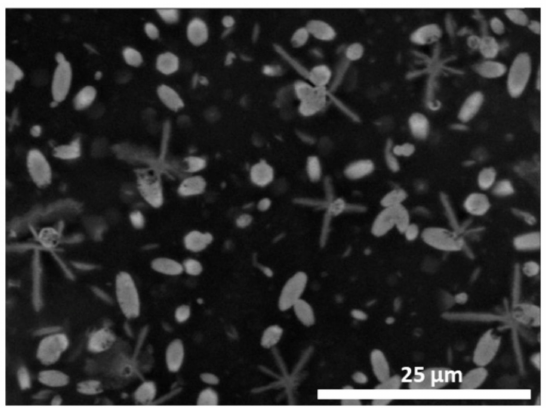
Figure A6. Change in morphology from spherical assemblies to oval assemblies at high loadings of drugs (2 mM). Star shaped assemblies are also emerging, mostly consisting of titanium, sodium and phosphorous according to EDS. These structures are presumably formed through evaporation induced self-assembly (EISA) during drying on the carbon tape (on SEM sample holder) from suspended NPs and sodium ions directed by the organic